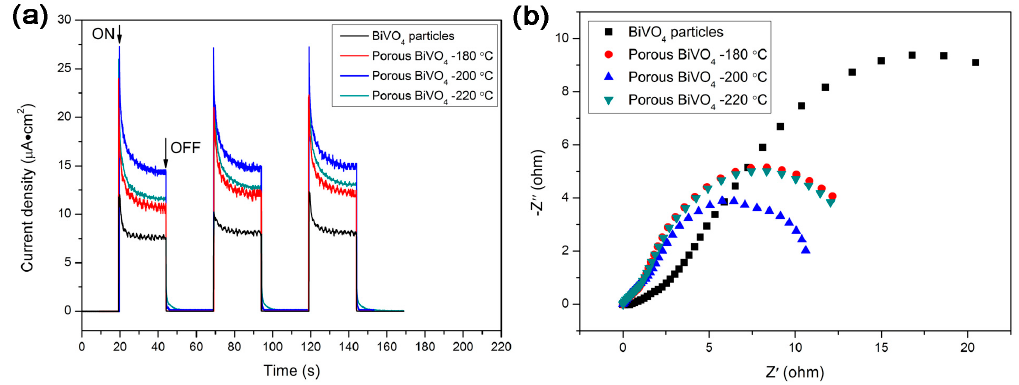
Figure 6. The photo-responses of as-prepared samples under visible light ( a ) and electrochemical impedance spectra ( b ) of these samples.